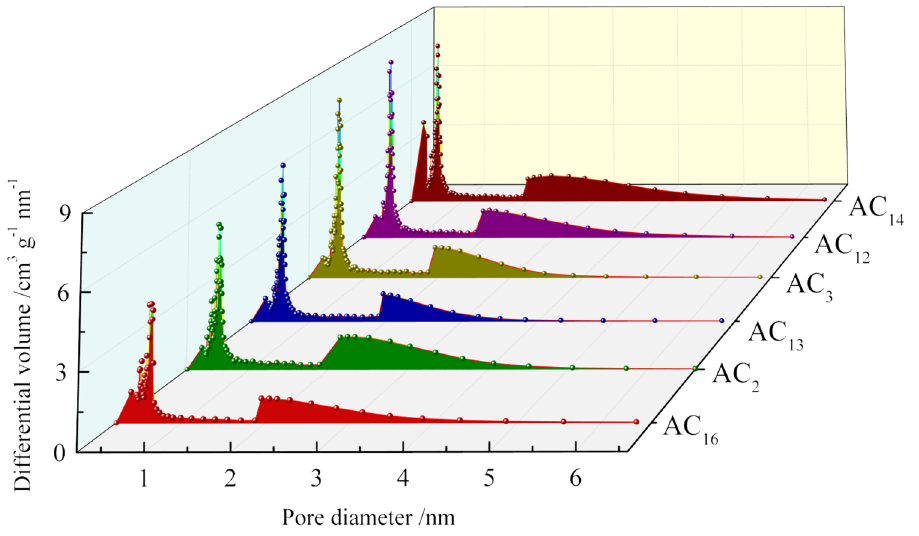
Figure 5. Pore diameter distribution of